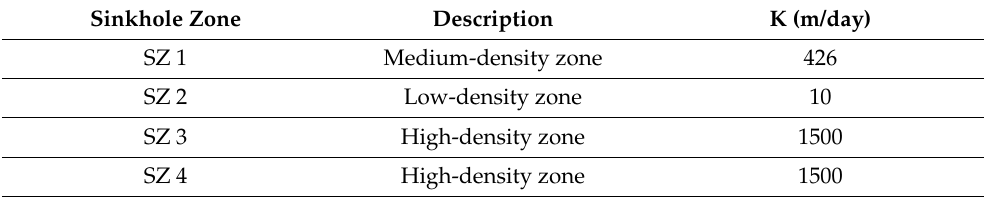
Figure 2. Sinkhole map showing spatial variation in sinkhole density ( left ). Delineation of four sink- hole zones with each being assigned different hydraulic conductivities ( right ). Table 1. Specification of sinkhole zones and initial